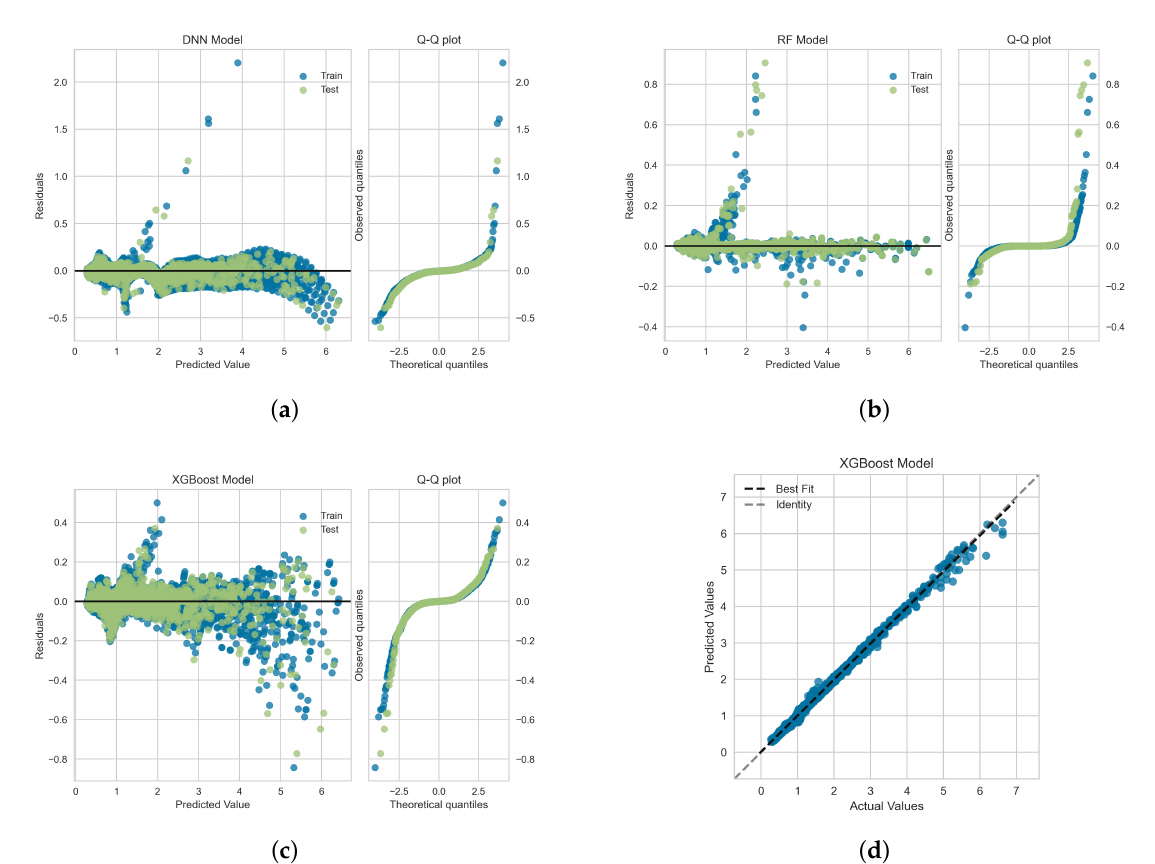
Figure 10. Residuals and quantile-quantile (Q-Q) plots obtained for the ML algorithms trained, validated and tested on SMOTE-set : ( a ) Neural Network, ( b ) Random Forrest, and ( c ) XGBoost models. Panel ( d ) shows the prediction error plot for XGBoost that yields the highest R 2 as reported in Table